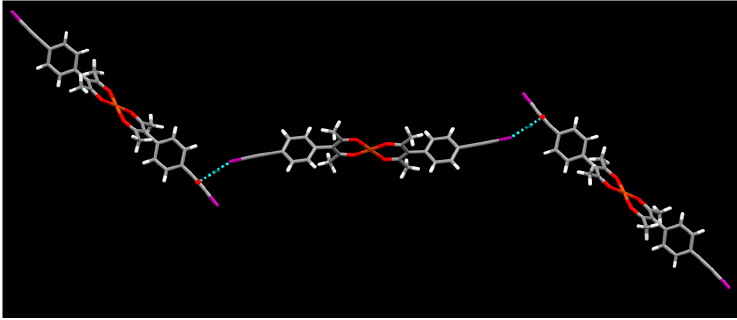
Figure 16. Halogen··· π interactions in the structure of [Cu( L3 ) 2 ] (color codes: red—oxygen; purple—iodine; orange—copper).